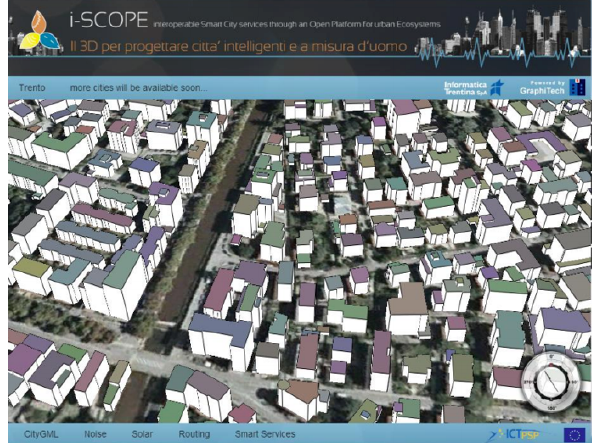
Figure 3 LoD1 model of Trento visualized into i_SCOPE 3D